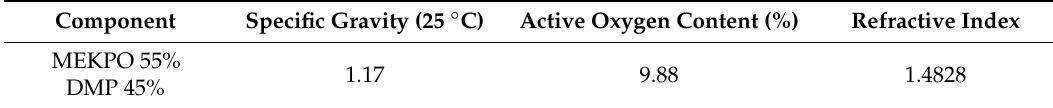
Table 2. Properties of the initiator.